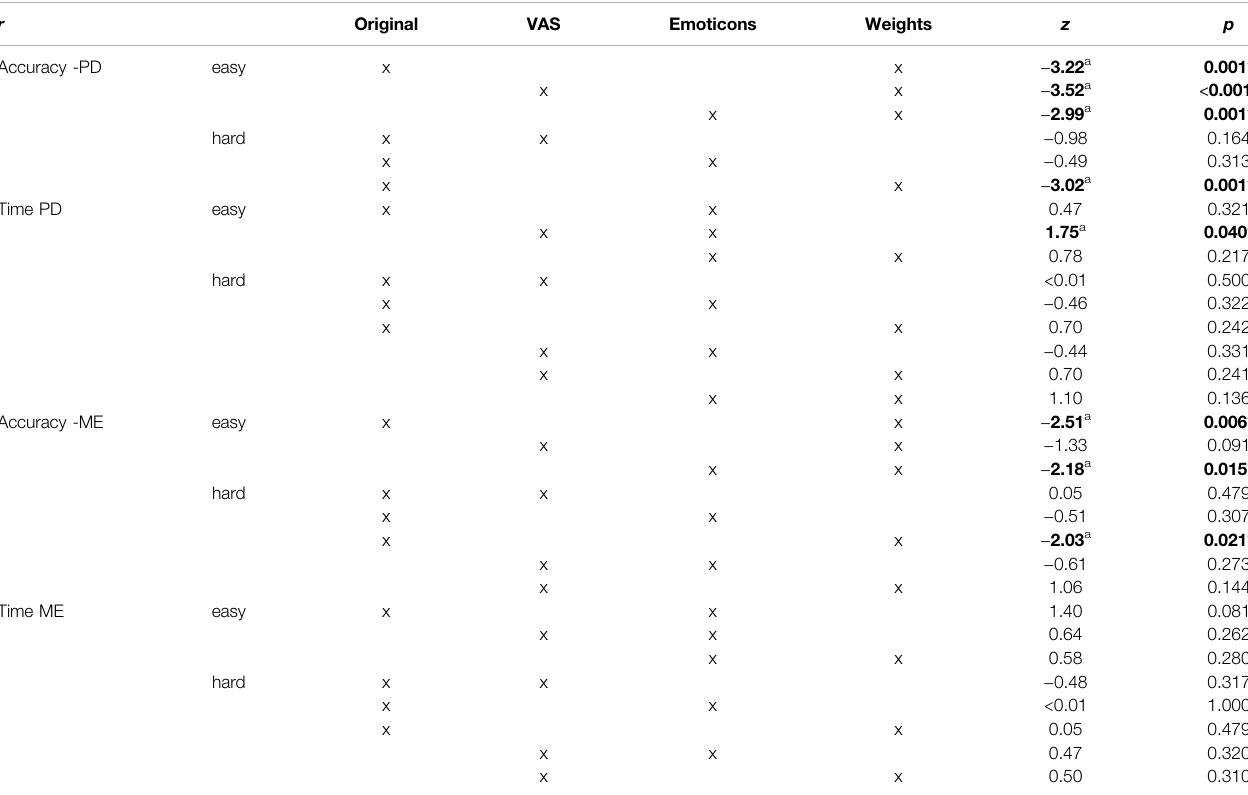
TABLE 6 | Comparisons of Correlations between the Scale types.